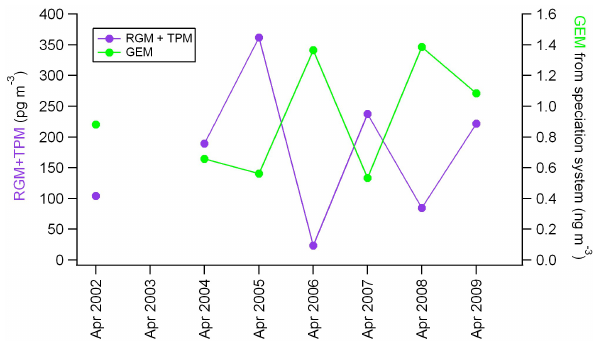
Fig. 7. Monthly median concentrations of GEM and the sum of RGM and TPM at Alert in the month of April. Only months with > 75% data coverage are